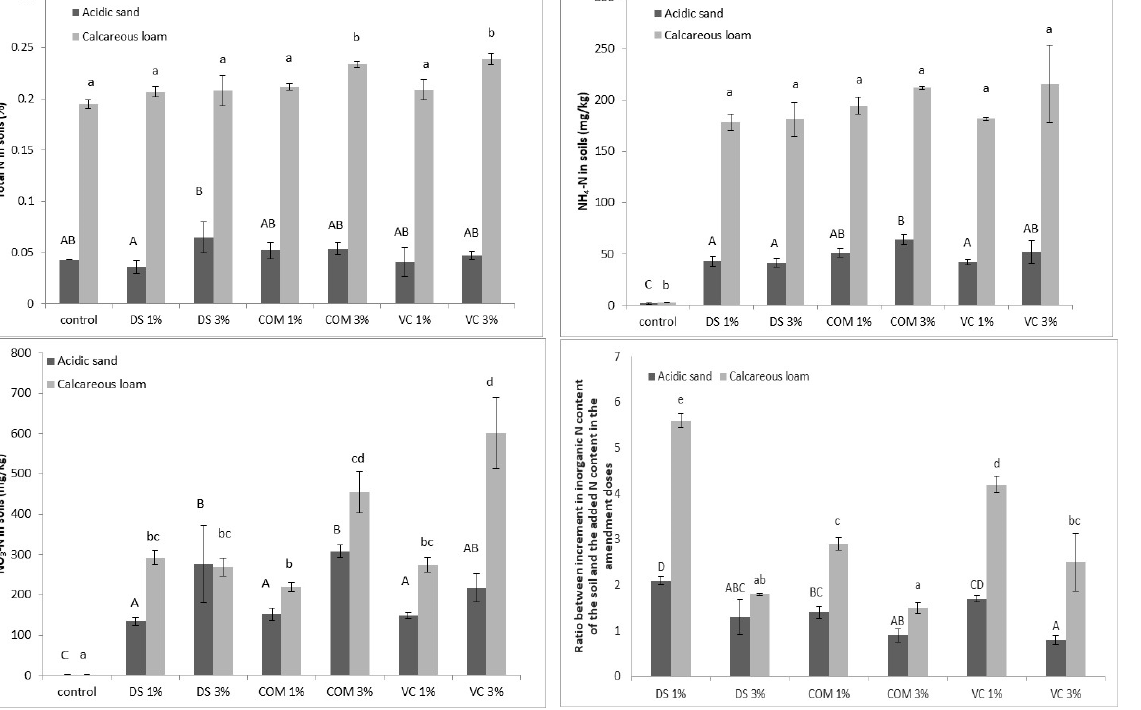
Figure 2. Changes in the concentration of total N, NH 4 -N, and NO 3 -N, as well as the ratio of the increment in the inorganic N (NH 4 -N + NO 3 -N) content of the soil to the N added with the amendments 75 days after the application of digested sludge (DS), digested sludge compost (COM), and digested sludge vermicompost (VC) in 1% and 3% doses. Error bars represent the standard deviation (SD) of the mean with 3 replicates. Uppercase letters indicate significant differences between treatments on acidic sand and lowercase letters indicate significant differences between treatments on calcareous loam ( p < 0.05).